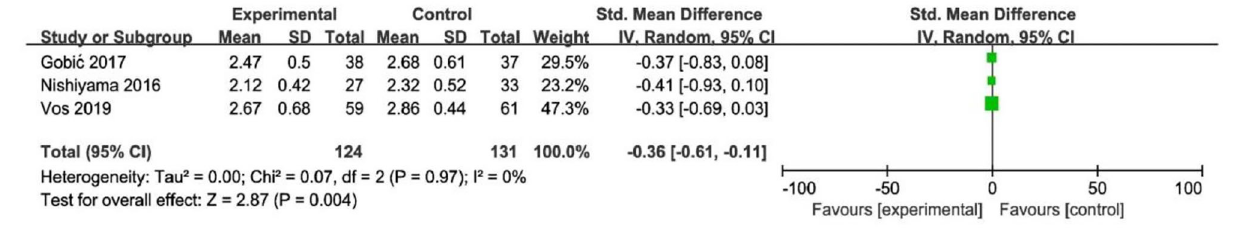
FIGURE 9 | Meta-analysis of the effects of DCB compared with control in MLD2.